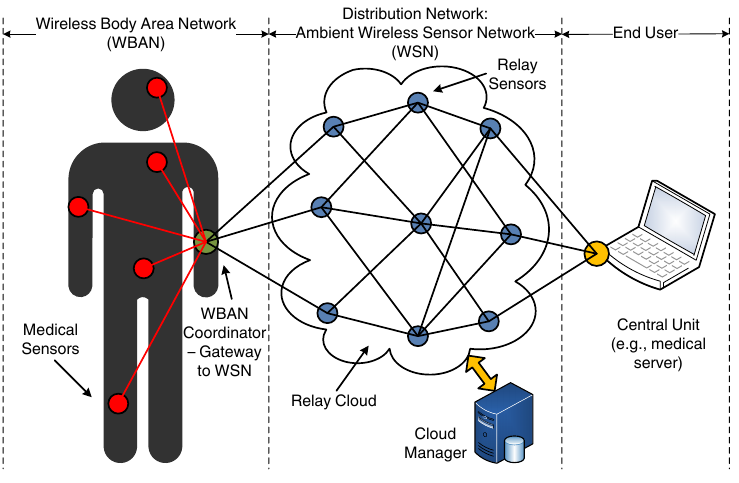
Figure 1. Framework of the end-to-end healthcare